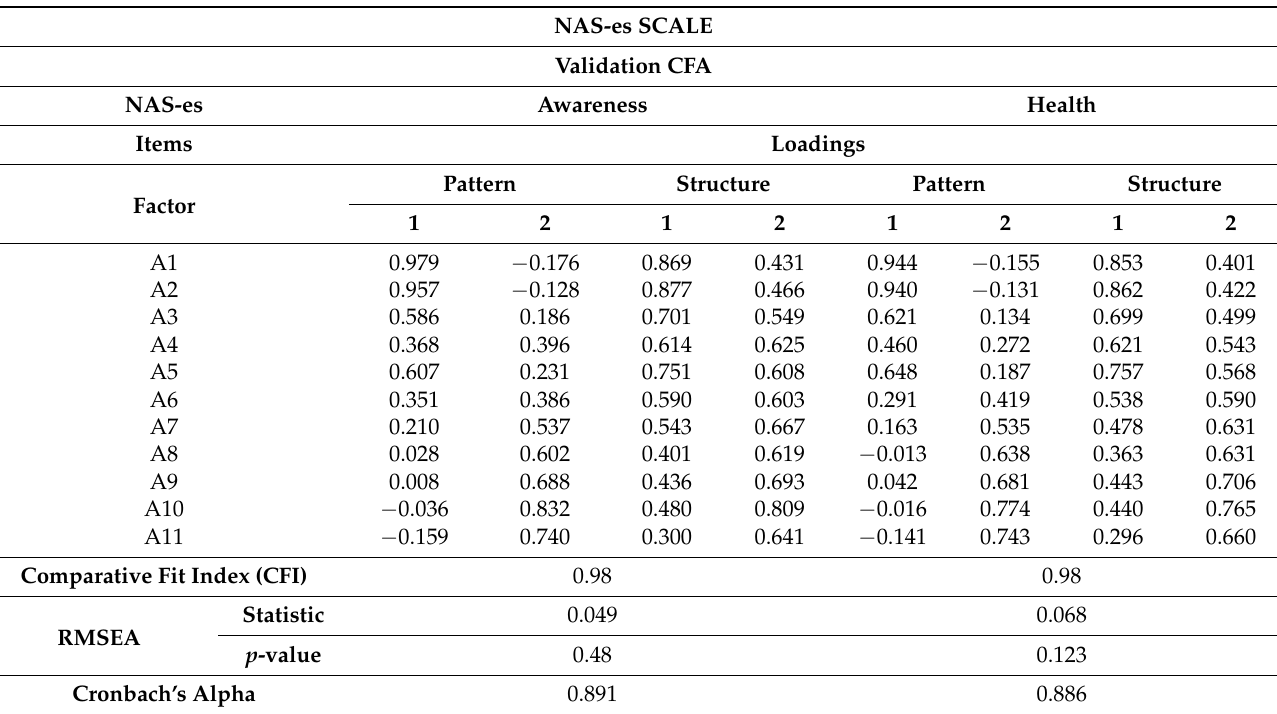
Table 3. Factor loadings and Cronbach’s alphas for the Nurse Awareness Scale (NAS-es) of the questionary NEAT-es 1st version CFA (n = 376